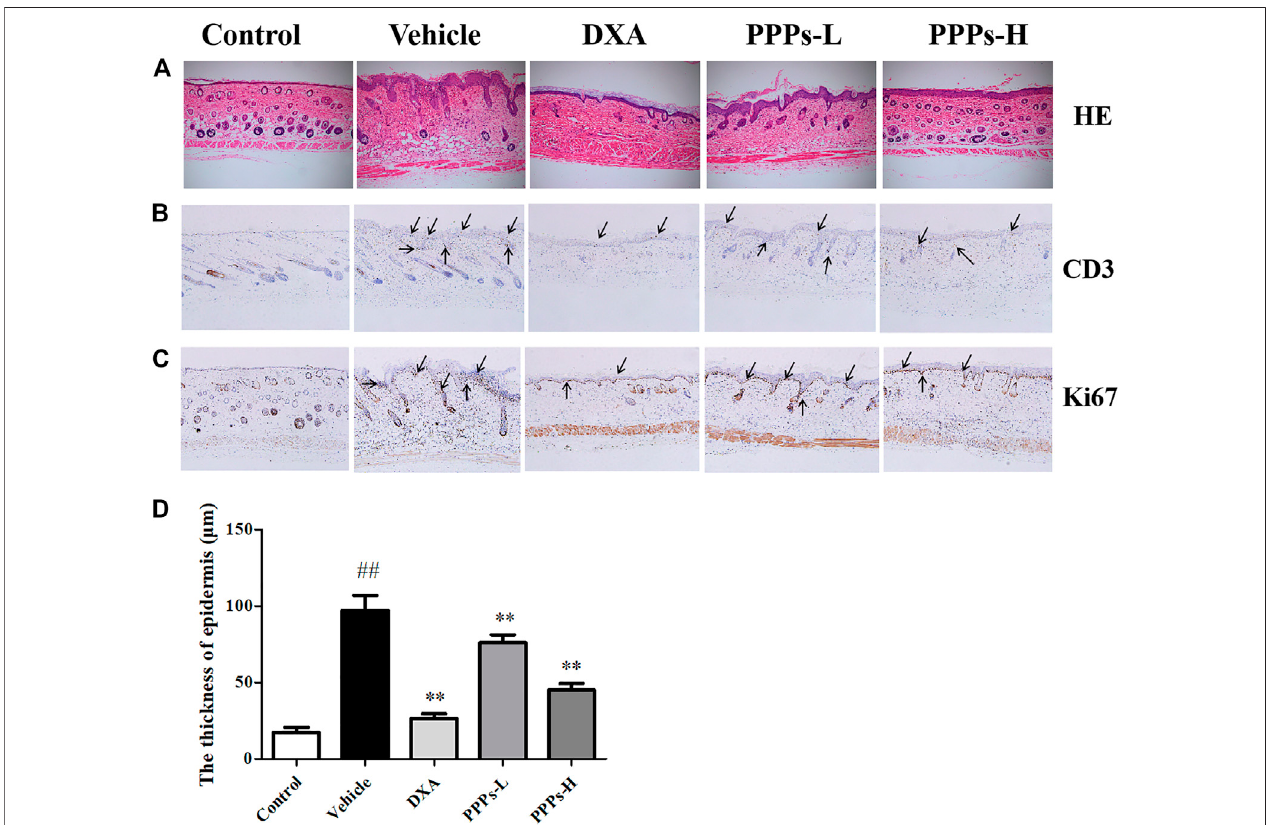
FIGURE 4 | Histological analysis and immunohistochemistry assay. Different treatments were administrated to mice. H&E staining (A) of the dorsal skin lesion in differentgroups.ImmunohistochemicalphotographsofCD3 (B) andKi67 (C) staining(magni fi cation, × 100)ofthedorsalskinincontrolorpsoriaticmicepost-treatment. The black arrows indicate the CD3 and Ki67 positive location. ## p < 0.01 compared with the control group; ** p < 0.01 compared with the vehicle group. PPPs-L , low- dose PPPs; PPPs-H , high-dose PPPs.